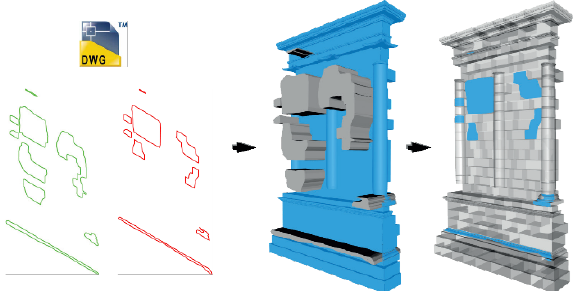
Figure 5: from the left the contours of the decay in CAD environment (the two different colors refer to different decays). Then, in the centre, the extrusion of the theme and the clash detection between the solid of the decay and the solid of the